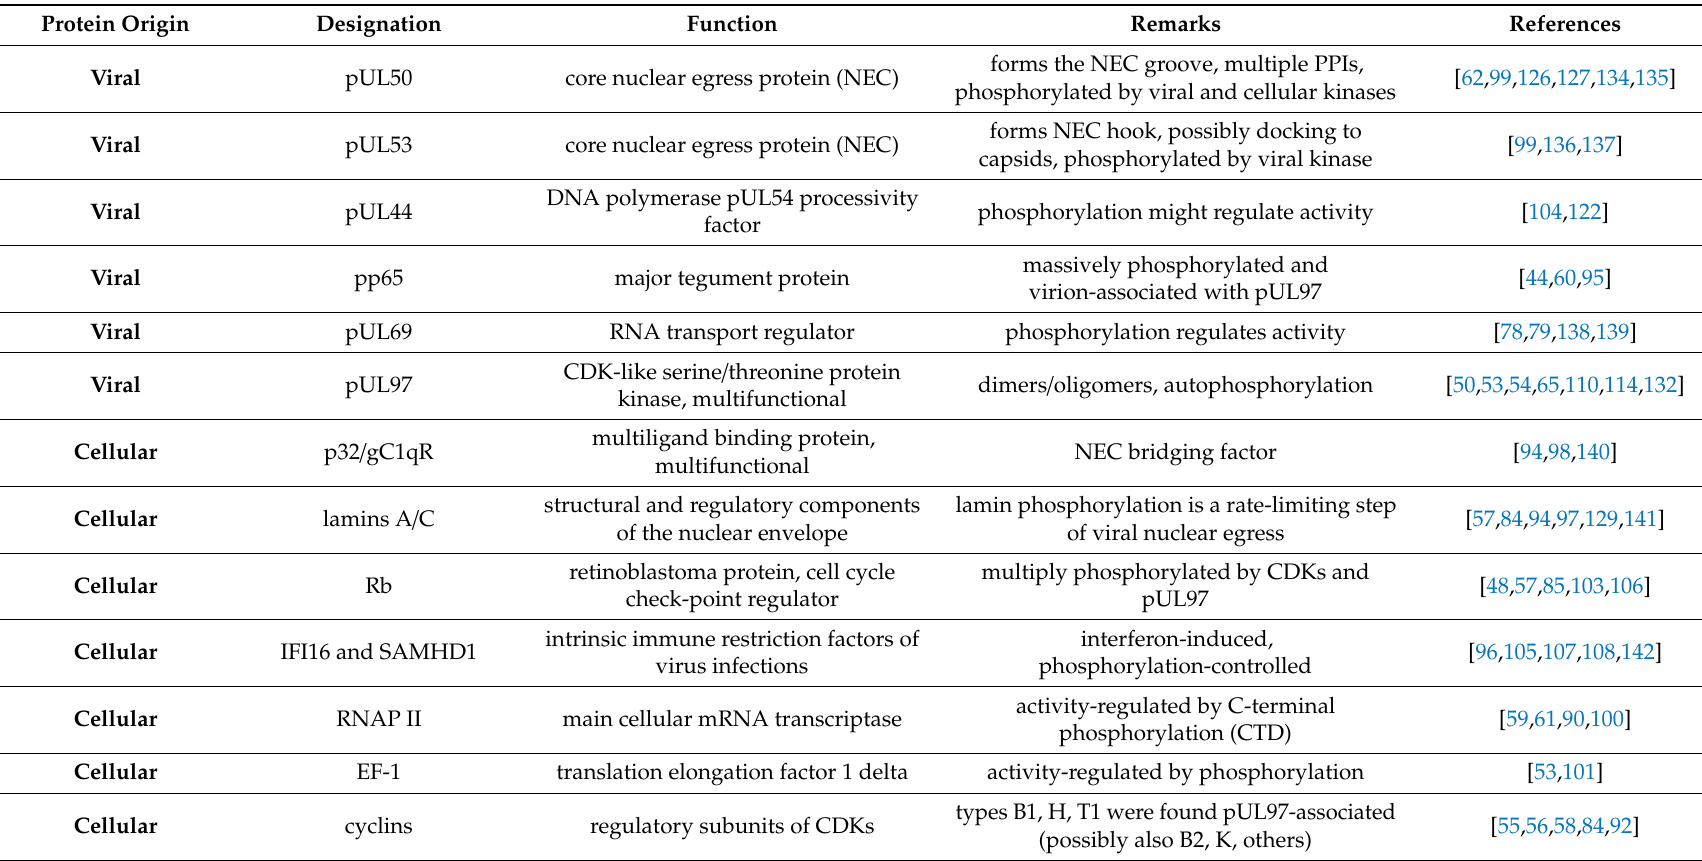
Table 3. Characteristics of viral and cellular substrate proteins of the HCMV vCDK pUL97 as well as pUL97-associated